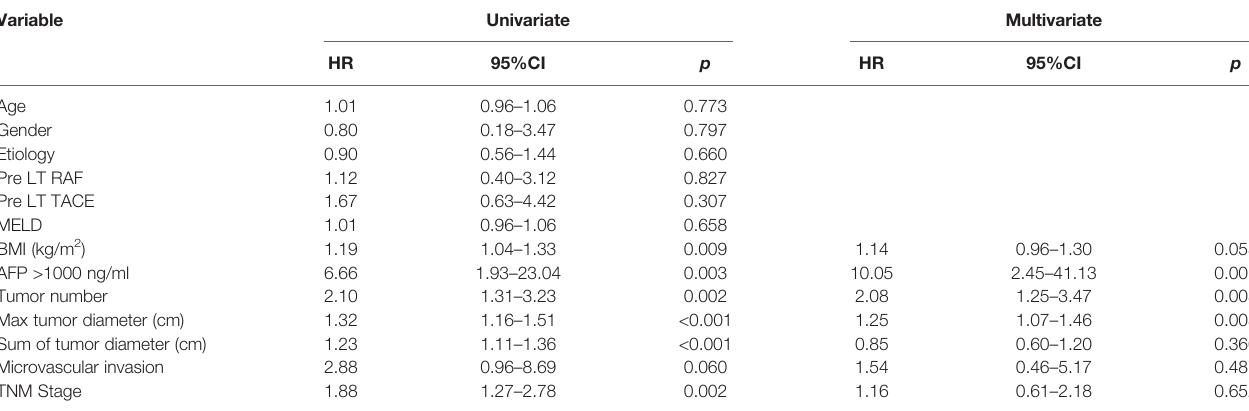
TABLE 2 | Risk factors for HCC recurrence on univariate and multivariate Cox regression analysis. Variable